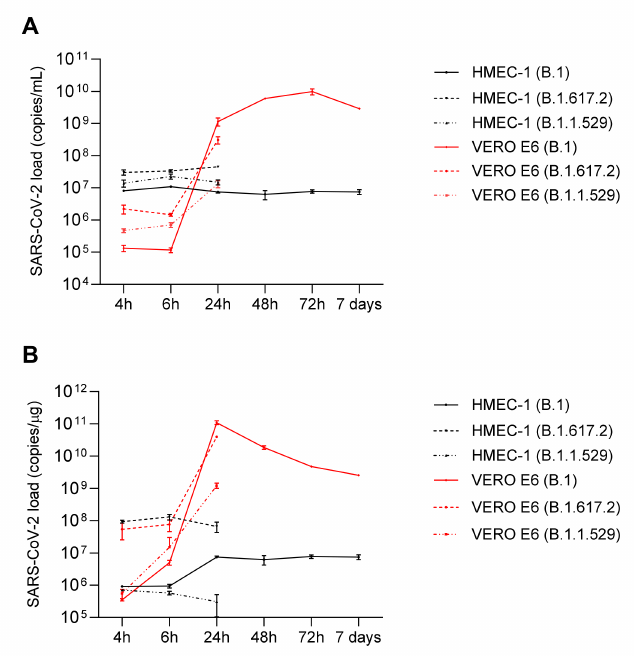
Figure 2. SARS-CoV-2 variants growth curves in HMEC-1 and VERO E6 cell lines. At 4, 6, 24, 48, 72 h and 7 days p.i., SARS-CoV-2 N1 gene expression in cell supernatants (panel ( A ): viral load expressed as copies/mL) and cellular RNA (panel ( B ): viral load expressed as copies/ µ g) of infected HMEC-1 and VERO E6 cell lines was evaluated by means of qRT-PCR.